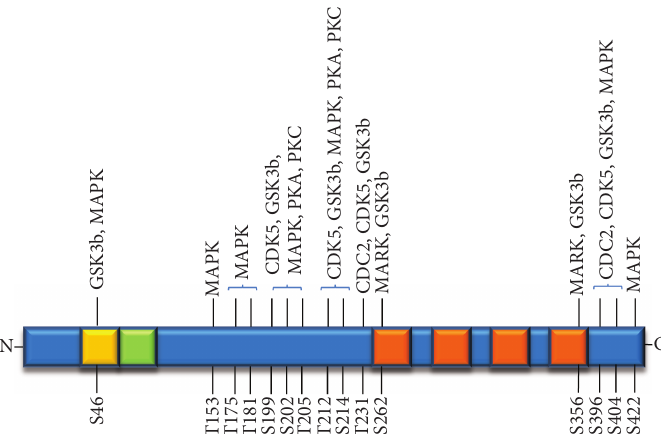
F 2: Sites of phosphorylation in tau and the kinases